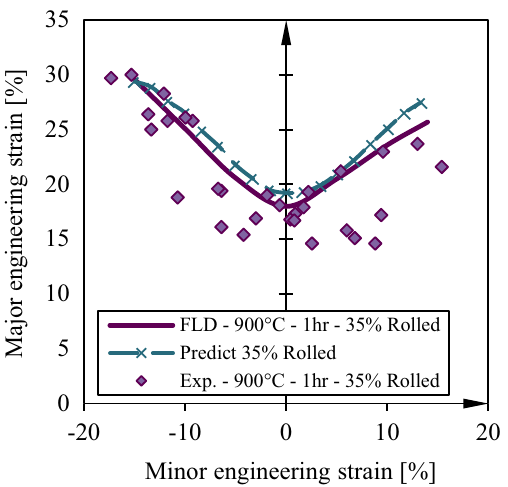
Figure 13. Effects of Thickness reduction in cold rolling process on forming limit curves for St14 sheet